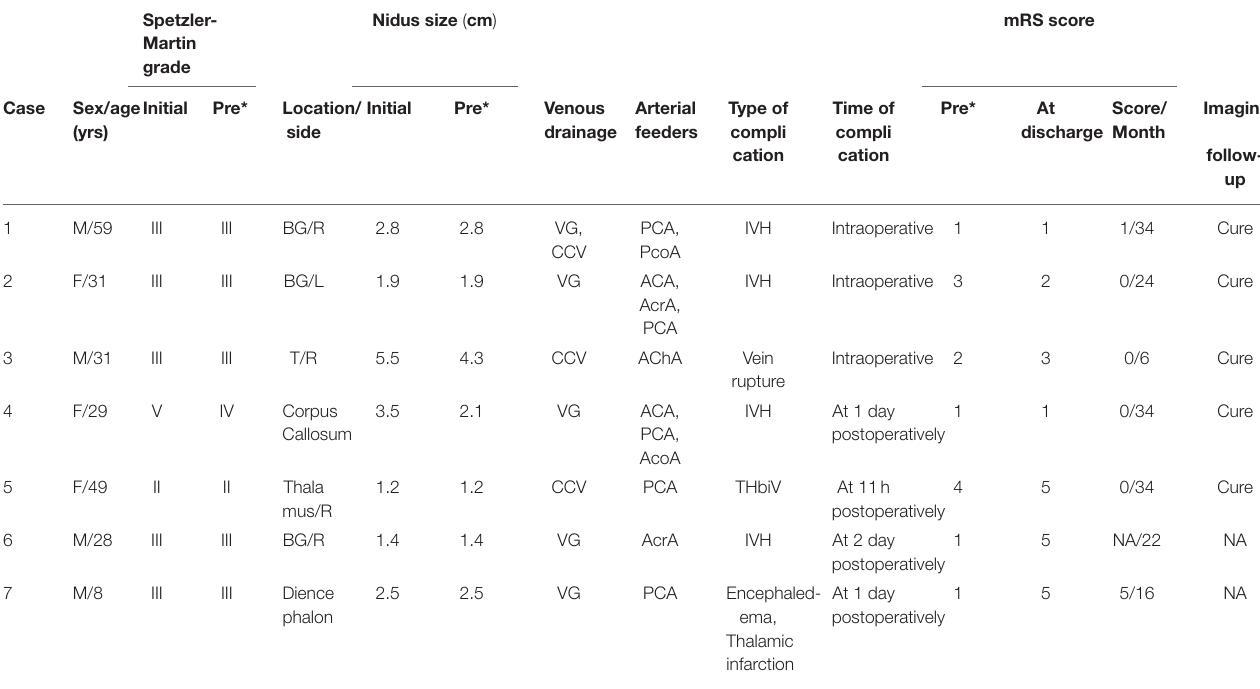
TABLE 1 | Characteristics of patients with complications and follow-up results. Spetzler-